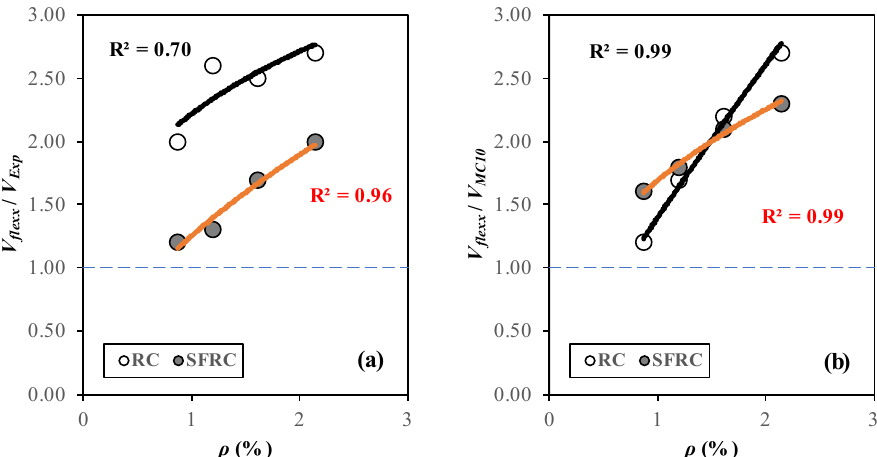
Figure 12. Influence of the flexural reinforcement rate on the failure mode: (a) Comparison with the V flex / V Exp relationship and (b) Comparison with the V flex / V MC10 relationship.